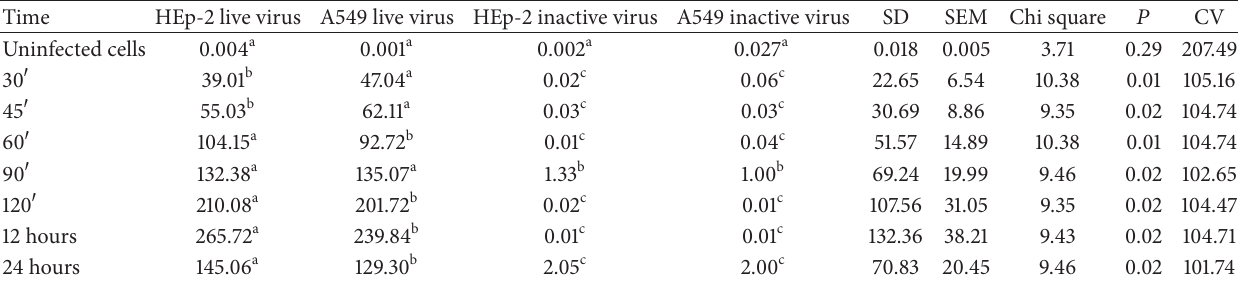
Table 1: IL-8 secretion (pg/mL) in HEp-2 and A549 cells infected with live and inactive virus.